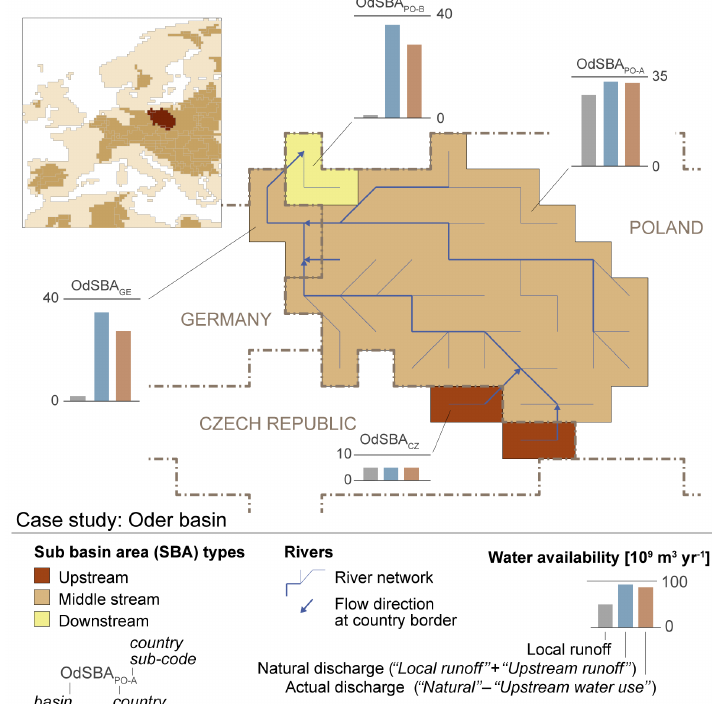
Figure 2. Upstream–downstream relationship between sub-basin areas (SBAs) in the Oder basin and average simulated annual water avail- ability for 1981–2010. Drainage network and sub-basin division are based on DDM30 (Döll, 2002) and country borders (Natural Earth, 2017) with additional manual assignment of border